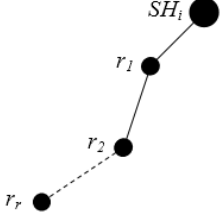
Figure 10. Hierarchy based on segmentation.